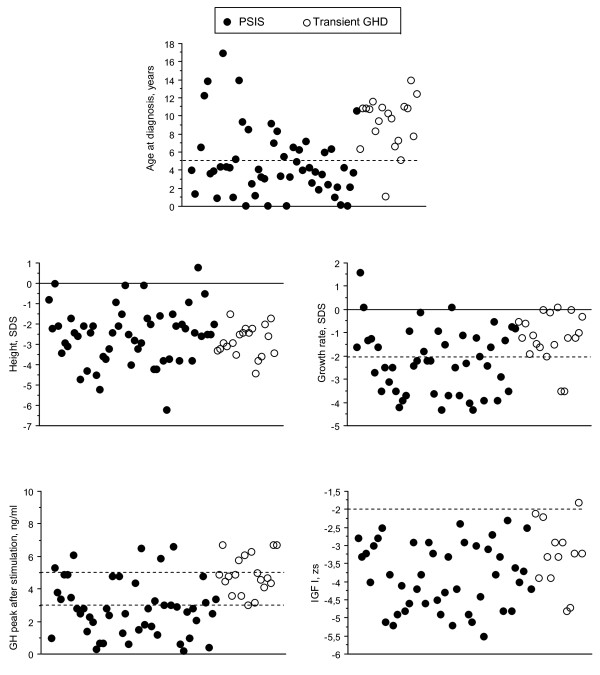
Characteristics at diagnosis.